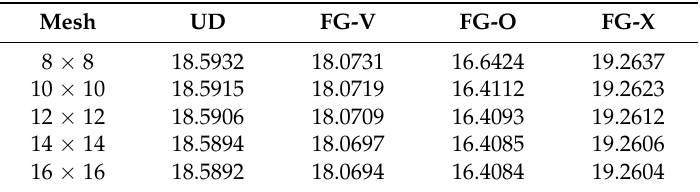
Table 2. Convergence of non-dimensional frequency of FG-CNT-reinforced clamped rhombic plate. Mesh UD FG-V FG-O